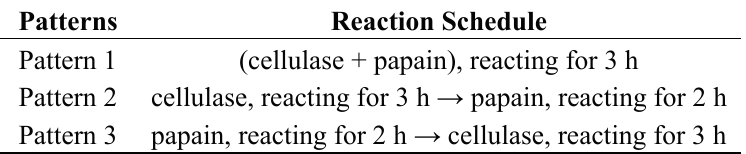
Table 2. Enzymatic treatment combination